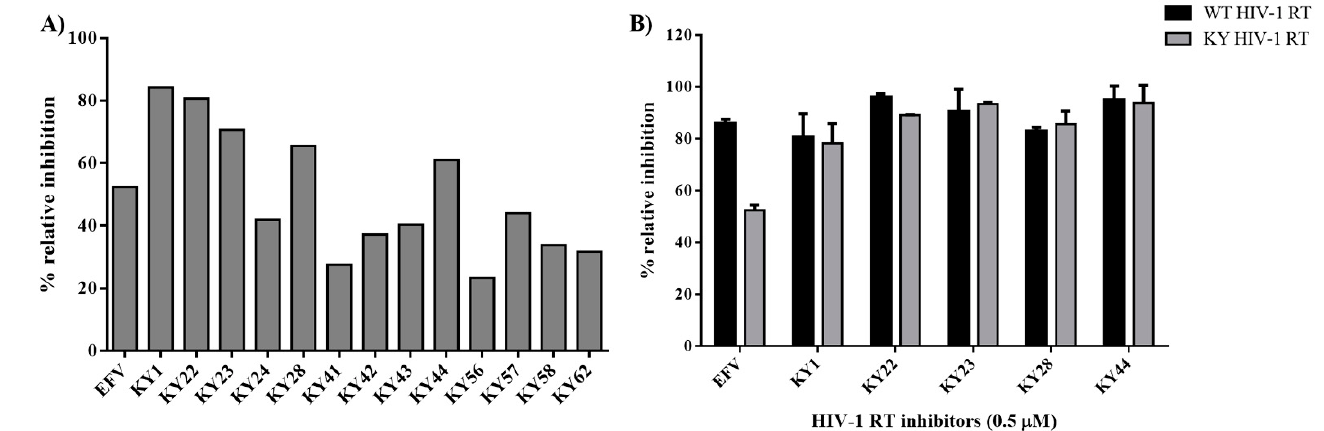
Figure 2. HIV-1 RTs DNA polymerase inhibition experiments. ( A ) Percent relative inhibition of amplified 13 KY DNA aptamers on KY-mutant HIV-1 RT function. ( B ) Percent relative inhibition of five synthesized KY DNA aptamers on both WT and KY HIV-1 RTs function. Data are represented as the mean ± SD ( n = 3).